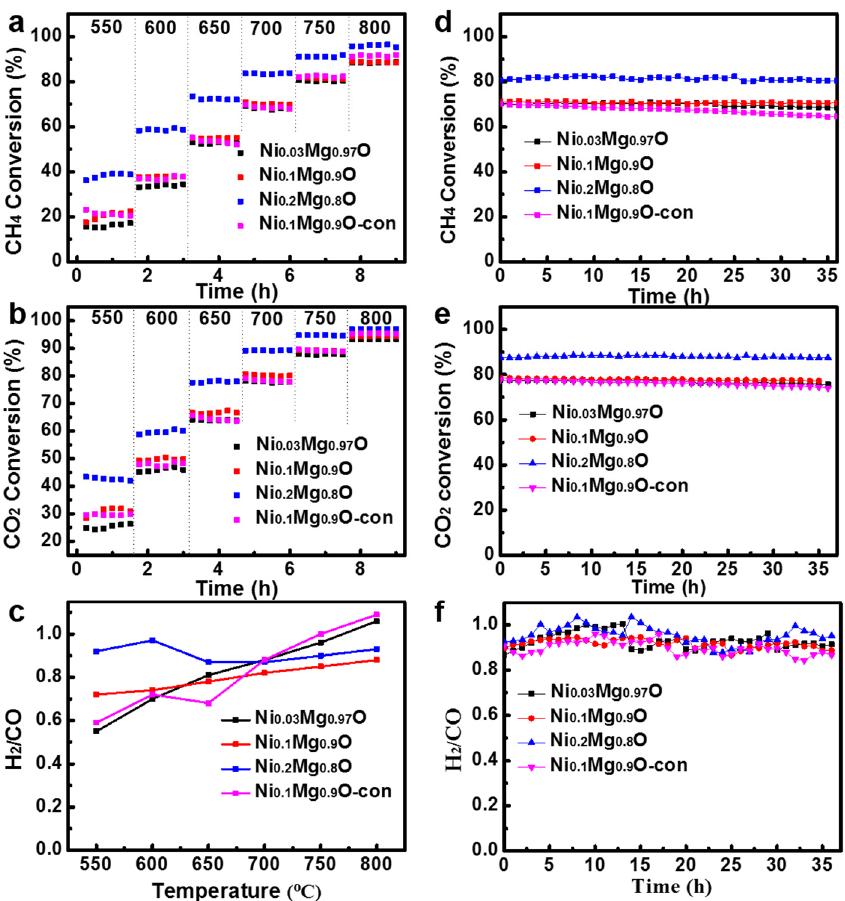
Figure 6. Catalytic activity of the Ni x Mg 1 − x O solid solution nanoplate catalysts and Ni 0.1 Mg 0.9 O-con catalysts for the CRM (Carbon dioxide reforming of methane). ( a )–( c ) CH 4 conversion, CO 2 conversion, and H 2 / CO ratio as a function of the reaction temperatures. ( d – f ) CH 4 conversion, CO 2 conversion, and H 2 / CO ratio for a 36 h continuous CRM reaction at 700 °C.